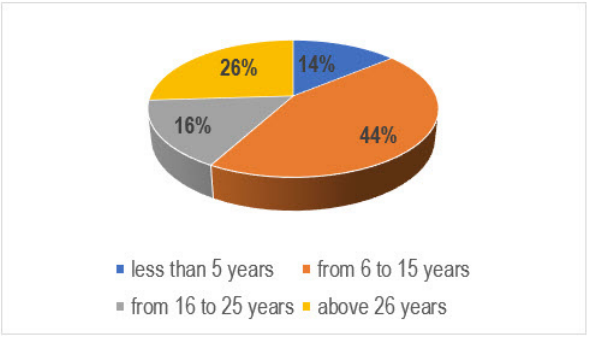
Figure 1. Length of working experience at school